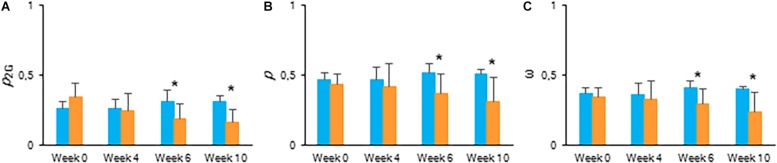
Calculated connectivity parameters derived from fast fluorescence kinetics measured at 08.00 h in young fully expanded leaves of Phalaenopsis “Edessa” at 0, 4, 6, and 10 weeks after growing under different light conditions, i.e., PPFD of 50 μmol m–2 s–1 (blue) and PPFD of 200 μmol m–2 s–1 (orange). (A) Overall grouping probability of PSII units when they are all open. (B) Connectivity parameter. (C) Probability of connectivity among PSII units when they are all closed (Strasser and Stirbet, 2001; Stirbet and Govindjee, 2011; Stirbet, 2013). Data are means ± SD (n = 15 plants). Asteriks indicate significant differences between different light conditions at P < 0.01 according to the independent sample t-test.